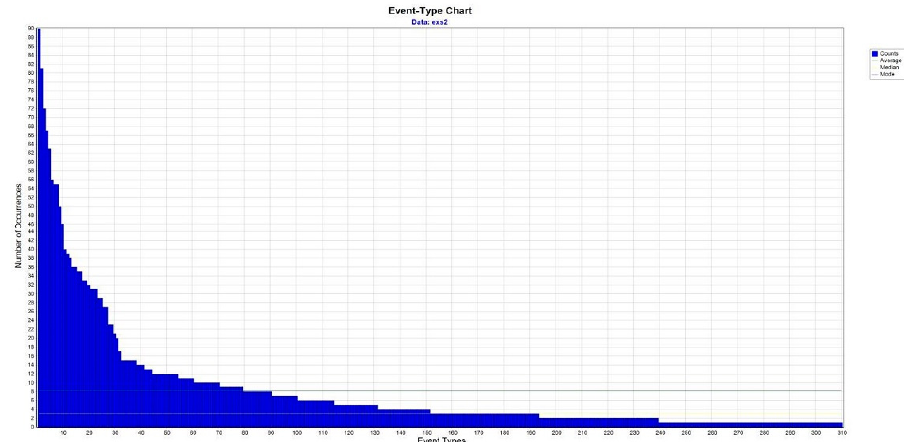
Figure 4. Distribution of event type during the second session.